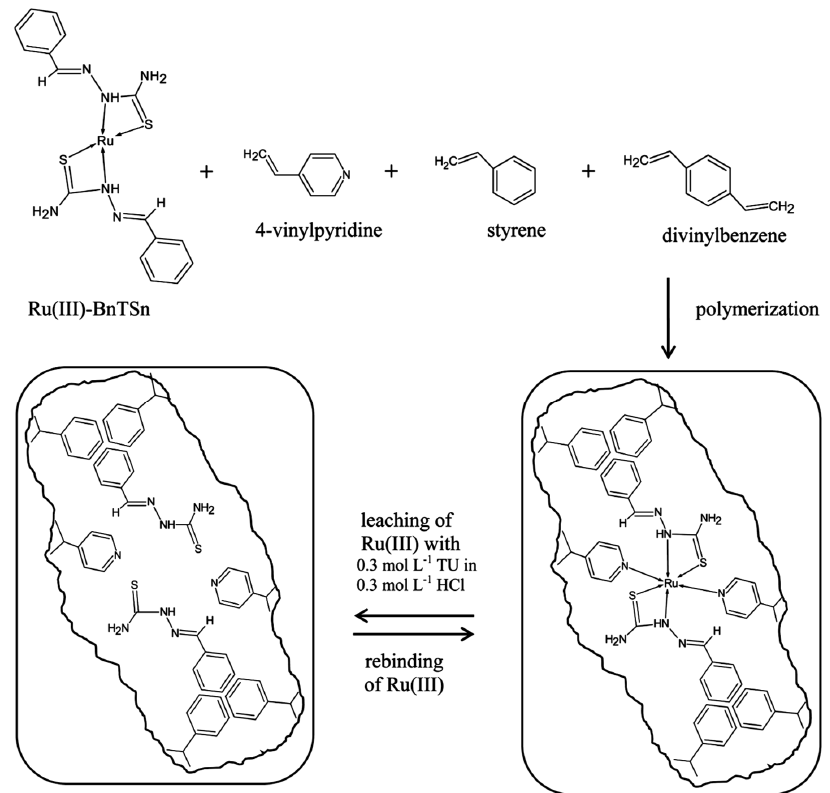
Figure 16. Schematic illustration of the preparation of the Ru–BnTSn (reproduced with permission from Ref. [165]. Copyright 2009 RSC